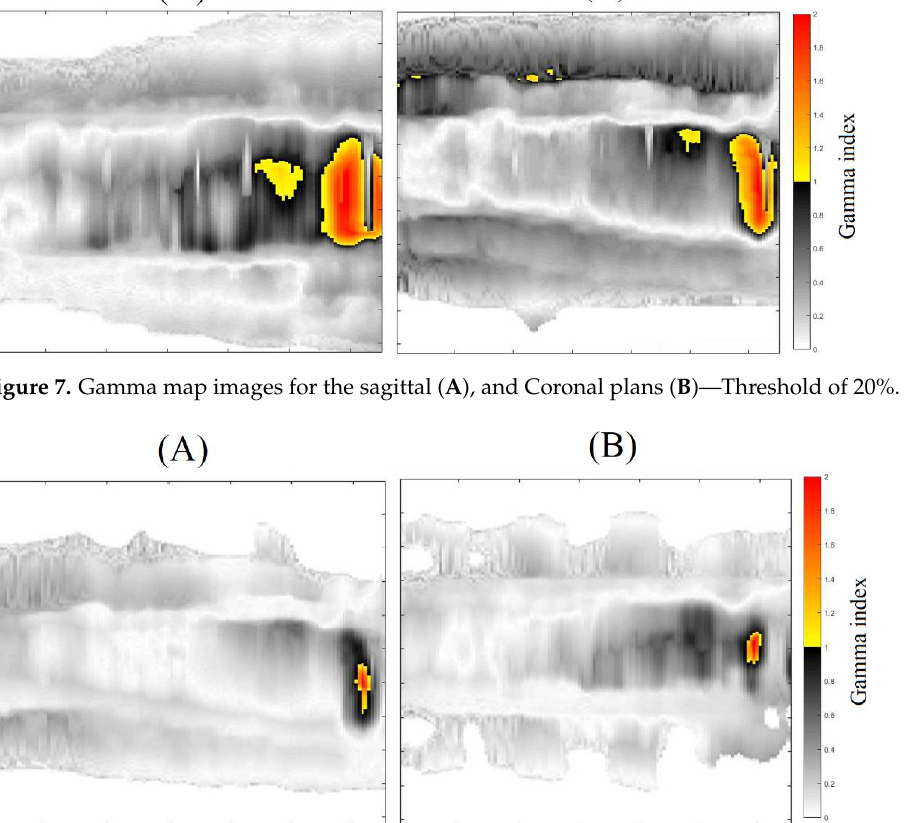
results are similar, indicating approximately the main fail region around the same position.